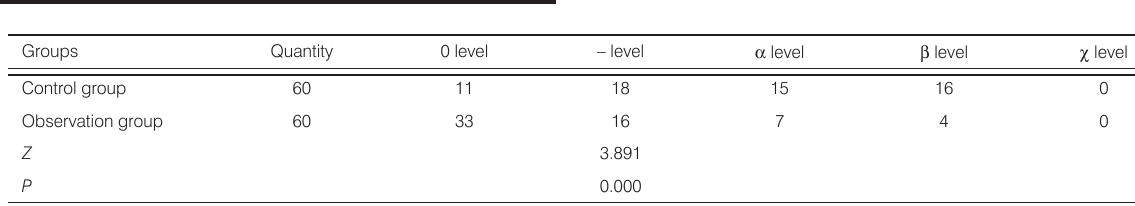
Table 3. Comparison of the frequency and degree of vomiting after the